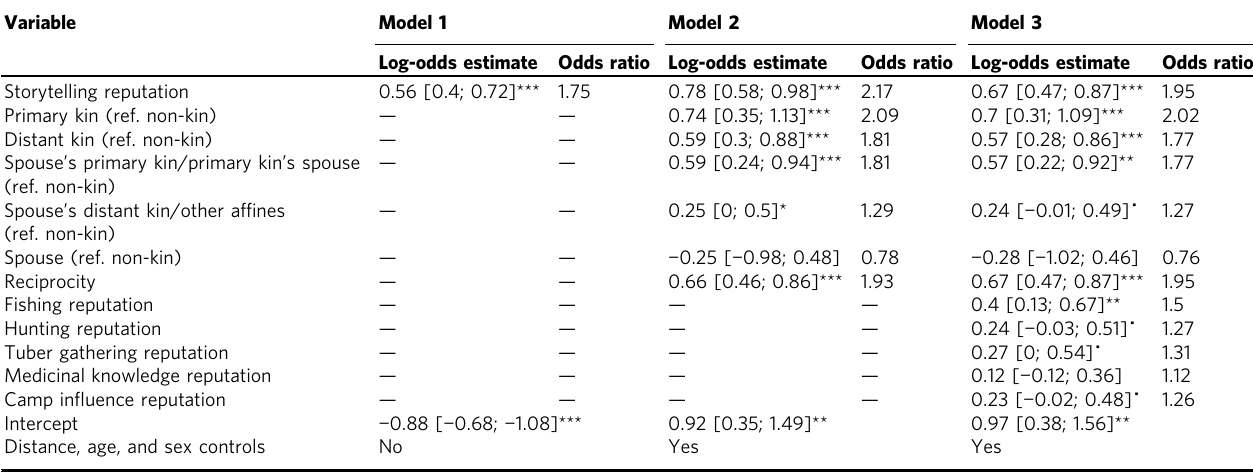
Table 2 Storytelling ability and camp-mate decisions Variable Model 1 Storytelling